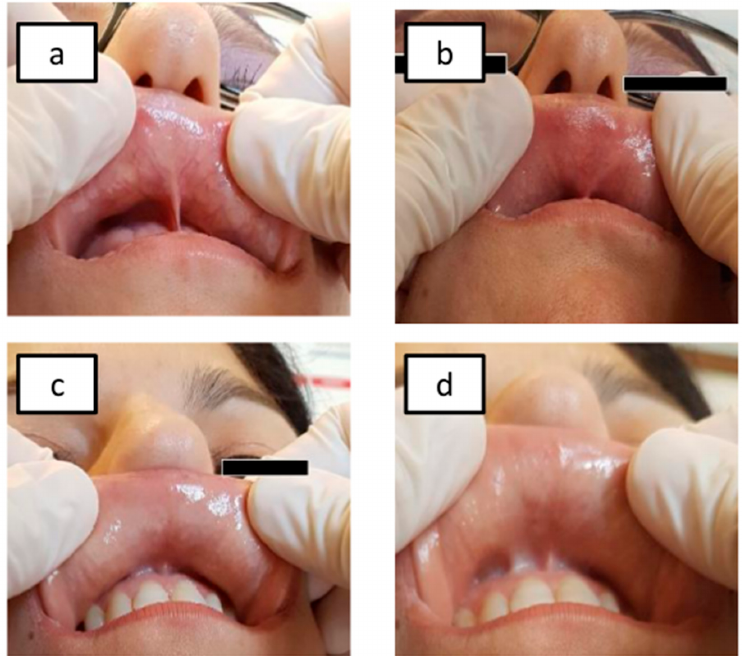
Figure 2. Ni omPT results: Ni-sensitive pts before Ni omPT application ( a ) and after Ni omPT removal (two hours) ( b ), non-Ni-sensitive pts before Ni omPT application ( c ) and after Ni omPT removal (two hours) ( d ). Legend: Ni omPT, nickel oral mucosa patch test; pts, patients.